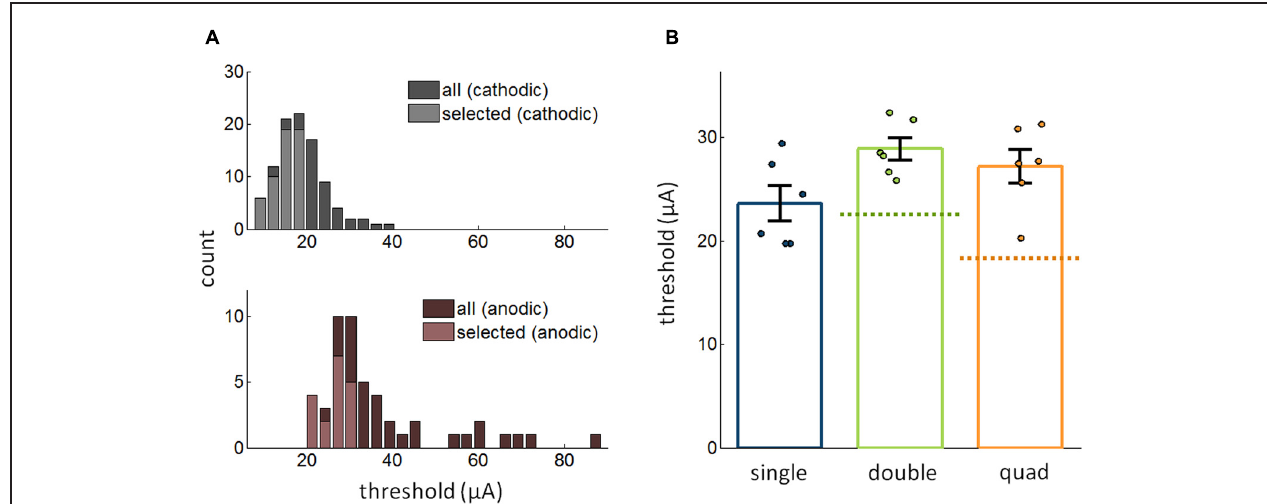
FIGURE 4 | (A) Distribution of thresholds for anodic phase leading and cathodic phase leading ICMS (56,021 trials from 97 electrodes). The distribution of thresholds for the best electrodes is shown in the lighter hue. (B) Comparison of